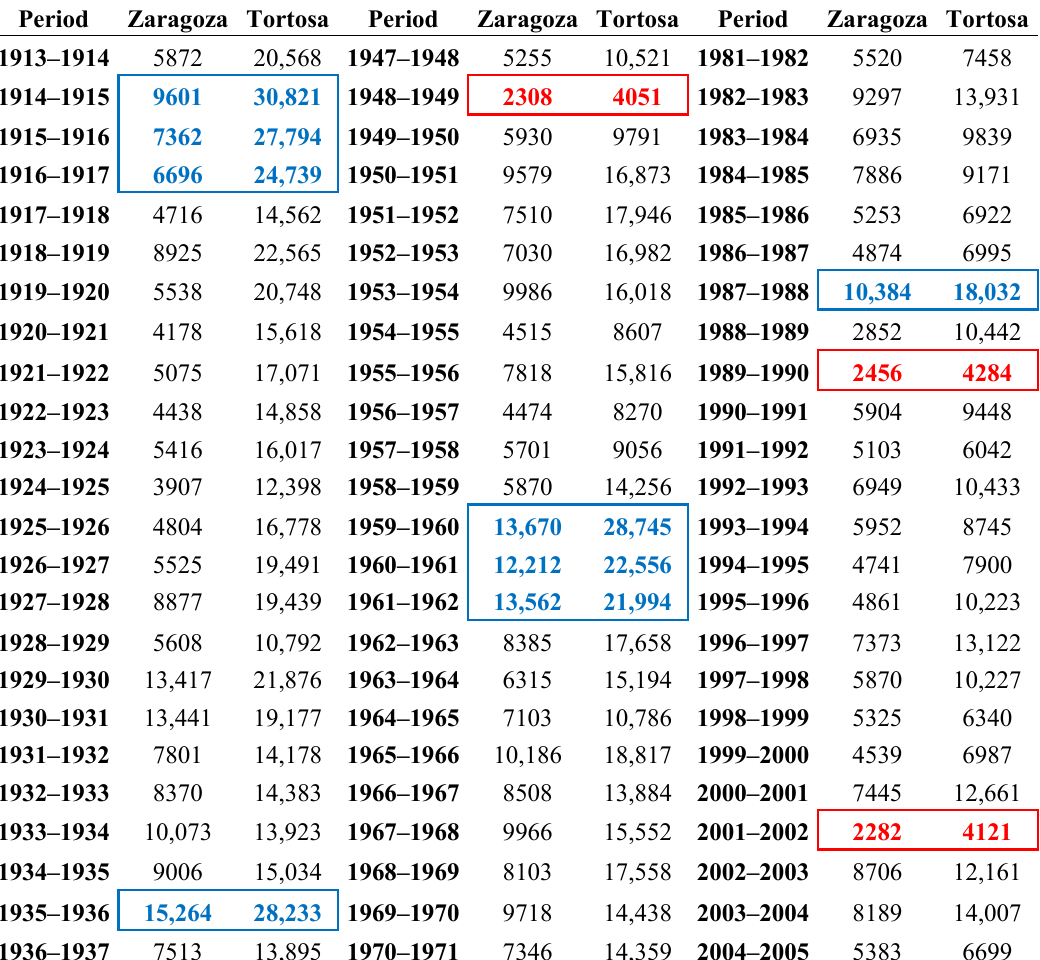
Table 1. Water flows in Zaragoza and Tortosa (hm 3